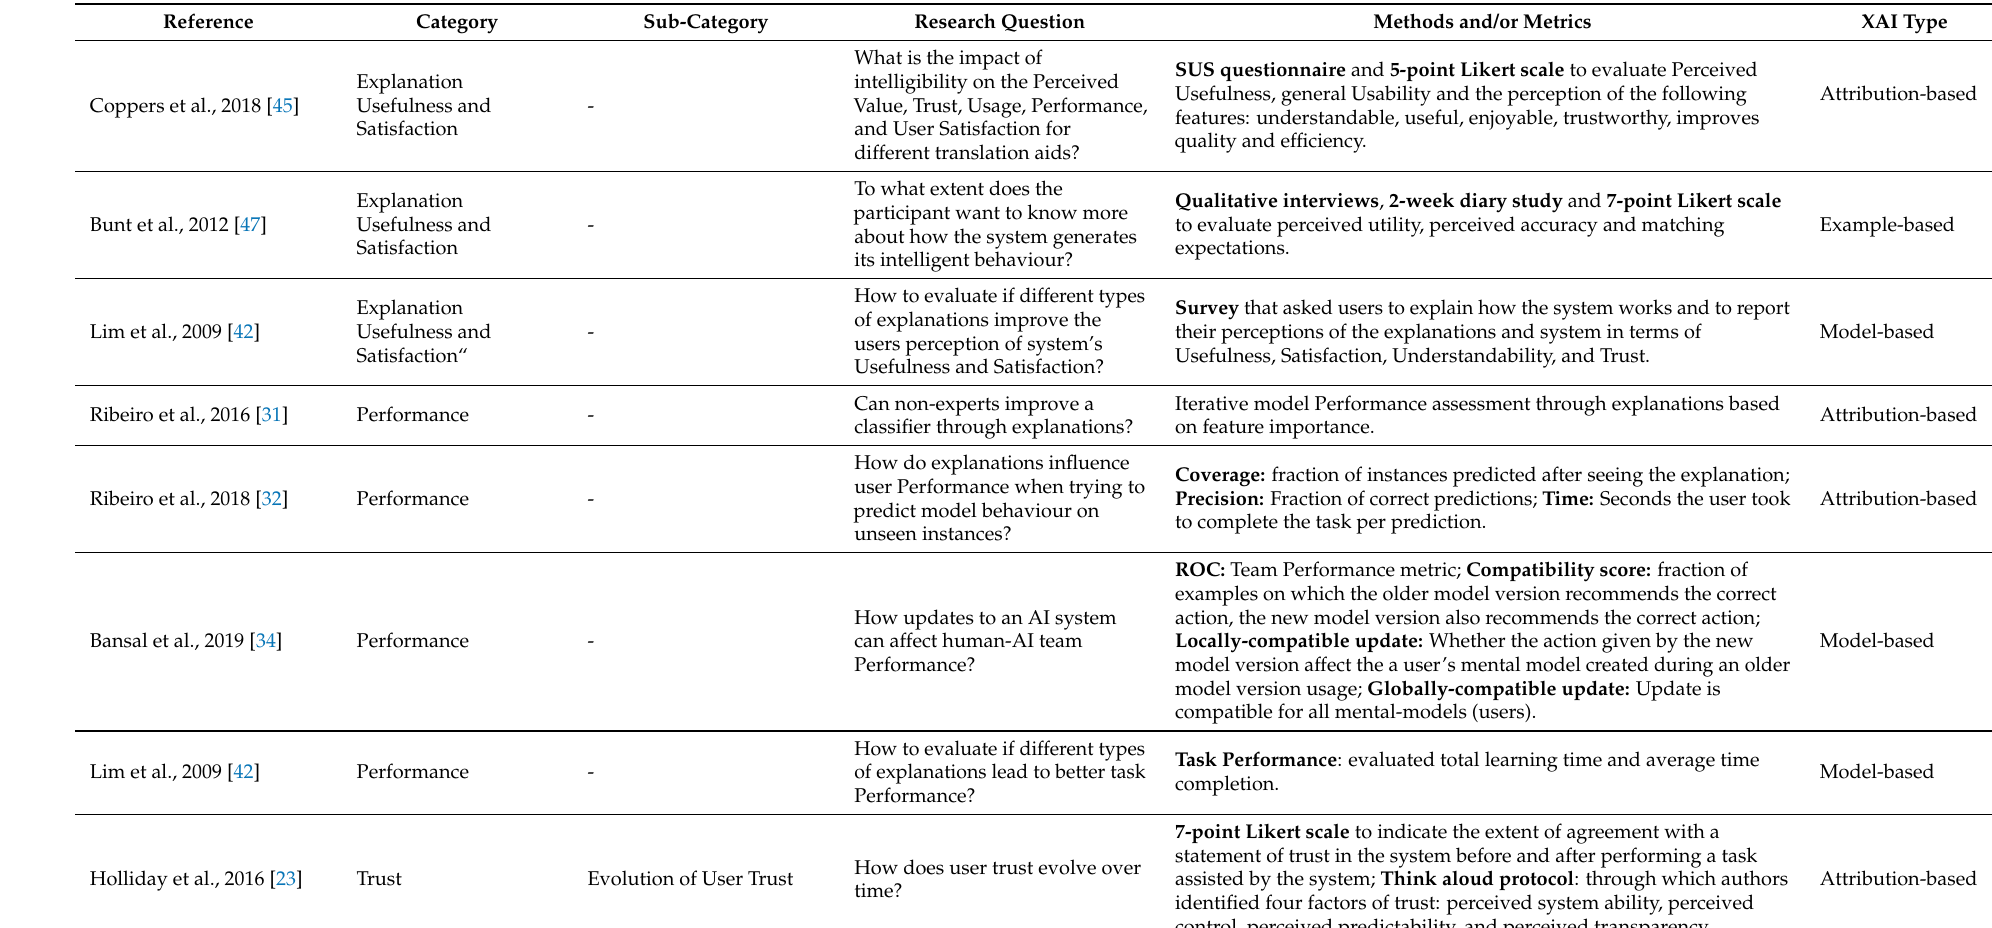
Table 3. Human-centred evaluation methods for machine learning